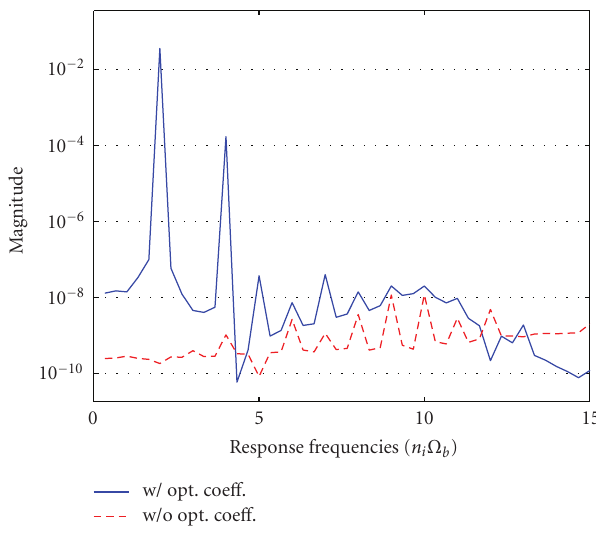
Figure 17: Horiz. response mag. profiles at Ω b = 0 . 1, bearing 1.